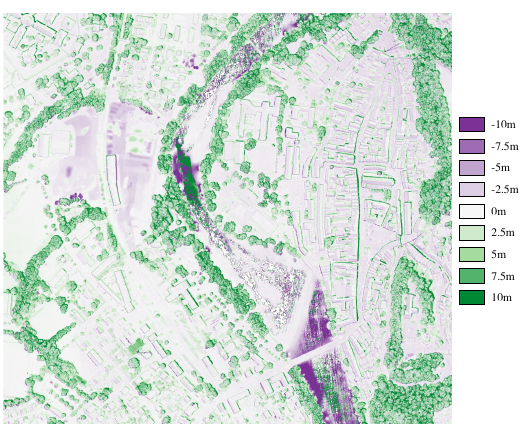
Figure 6. Visual comparison of different DSM generated using linear flight strips. (a) online direct georeferencing, (b) online bundle adjustment with 7 free images. (c) online bundle adjustment starting after two flight strips. (d) LiDAR ground truth .